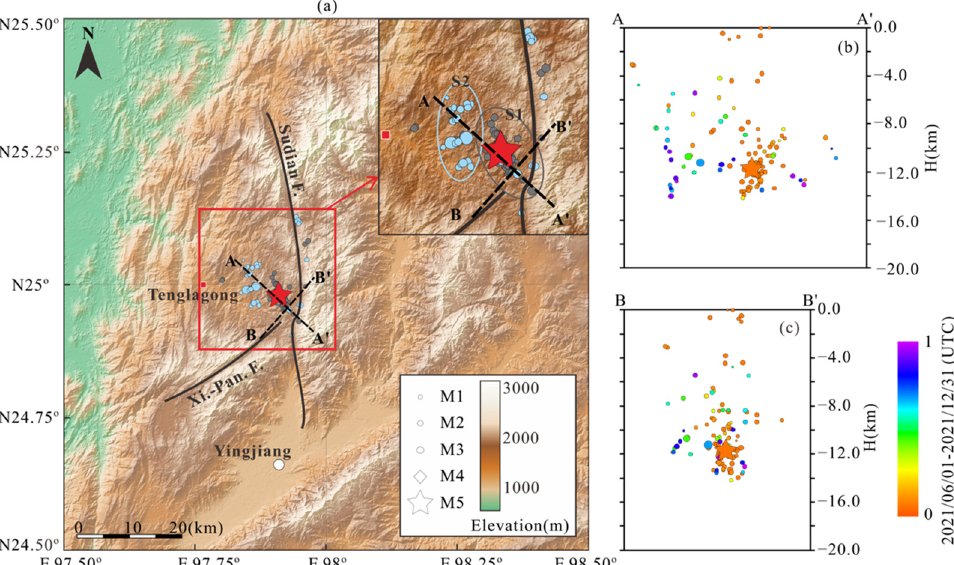
Figure 7. ( a ) Spatial distribution of the aftershock sequence following the 2021 M S 5.0 Yingjiang earthquake. According to the occurrence time, the aftershock sequence is divided into two subse- quences: gray (12 June 2021–3 September 2021) and blue (4 September 2021–31 December 2021). The red rectangle in the figure indicates the main distribution area of the aftershocks. The red star is the mainshock, and the small red solid square indicates the location of the Tenglagong hot spring. ( b , c ) Sections along the depth of the aftershock sequence.